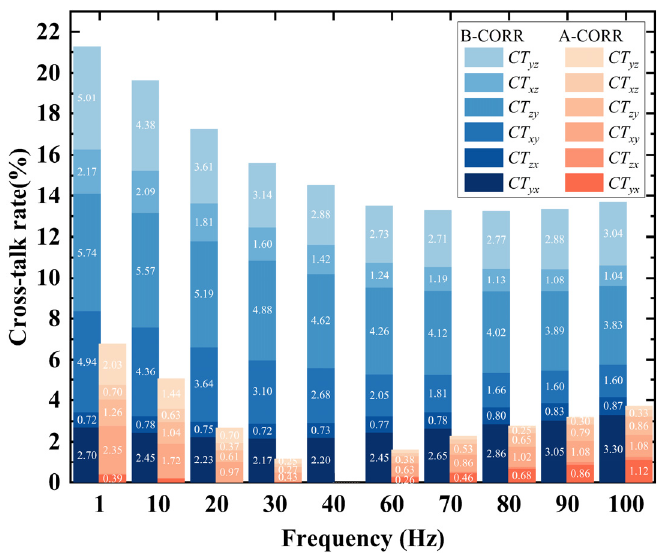
Figure 8. The coupling coefficient before and after correction. In the illustration, the left column represents the coupling coefficient before correction (B-CORR), and the right column is the data after correction (A-CORR). The correction matrix was the inverse matrix of the transfer matrix at 40 Hz. The values below 0.25% are not marked on the